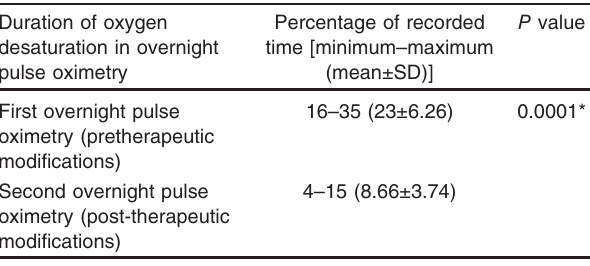
Table 4 Duration of oxygen desaturation before and after therapeutic intervention in group II Duration of oxygen desaturation in overnight